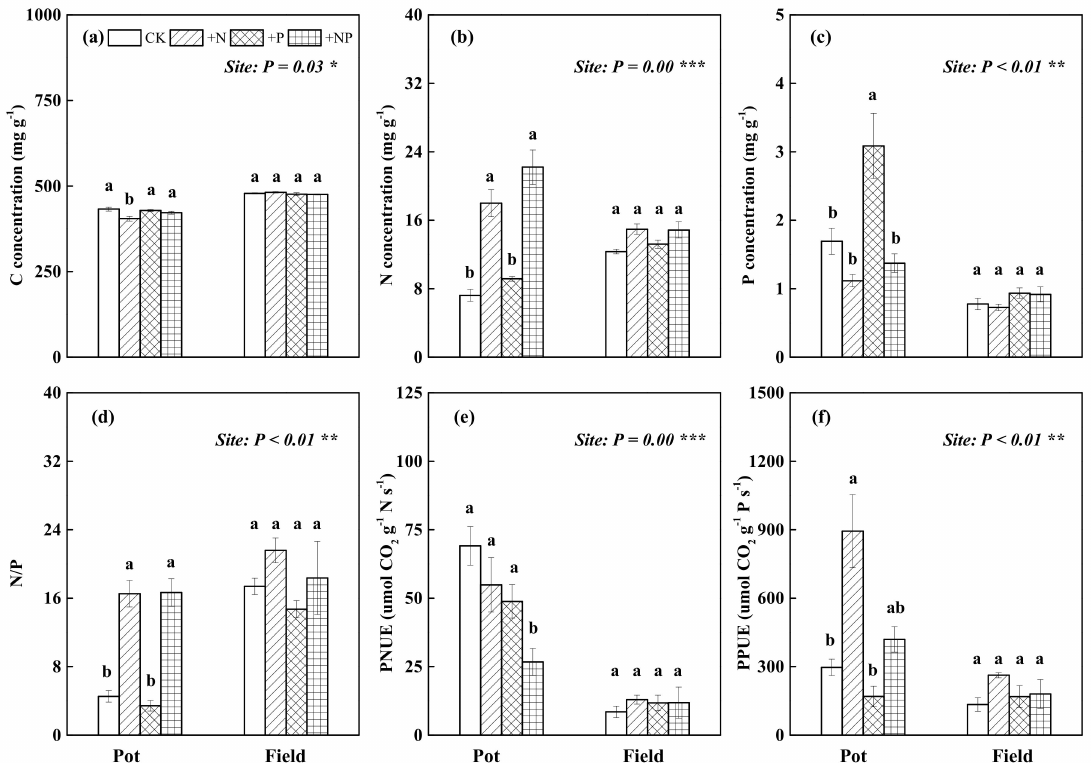
Figure 3. Leaf C ( a ), N ( b ), P ( c ), N/P ( d ), photosynthetic nitrogen use efficiency (PNUE) ( e ), and photosynthetic phosphorus use efficiency (PPUE) ( f ) of Schima superba under field and pot experi- mental nitrogen and phosphorus addition (CK = control, +N = nitrogen addition, +P = phosphorus addition, +NP = nitrogen plus phosphorus addition). Note: The bars indicate the standard error. The small letters indicate the differences ( p < 0.05) among the four treatments within field or pot experiments. p value indicates the difference ( p = 0.00, ***; p < 0.01, **; p < 0.05, *) between field and pot experiments. The bars indicate standard errors (field, n = 3; pot, n =